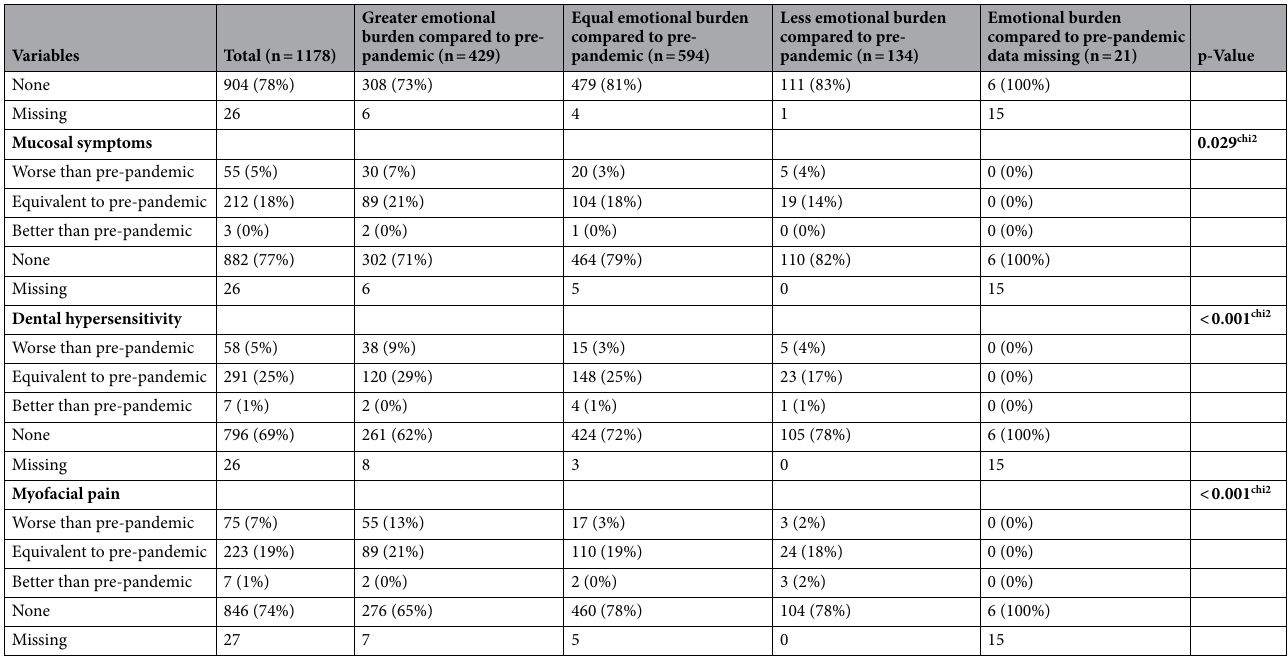
Table 2. Oral health-related parameters. Significant values are in bold. All missing values were excluded for statistical testing. n number of participants, COVID-19 coronavirus disease 2019, SD standard deviation, Q